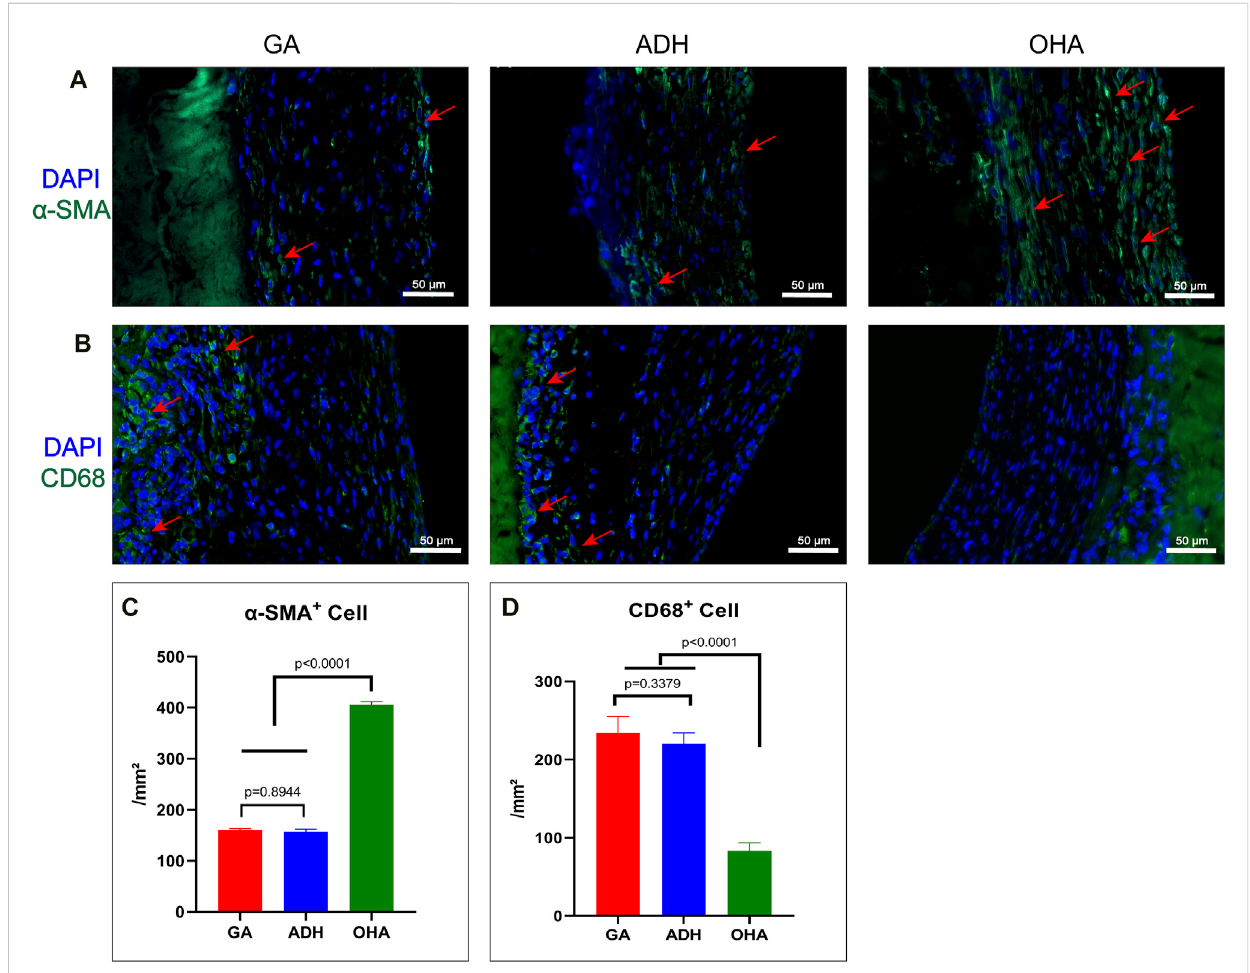
FIGURE 8 Immuno fl uorescence staining with α -SMA + antibody and CD68 antibody was performed to observe the in fi ltration of smooth muscle cells and macrophages in the neointima of the GA, ADH and OHA groups, and the corresponding quantitative analysis was performed at 4 weeks. Representative imagesofimmuno fl uorescencestainingwithanti- α -SMA(green)andCD68(green)antibodiesineachgroupat4 weeks.Nucleiwerecounterstainedwith DAPI. Scale bar, 50 μ m (A, B) . The number of α -SMA + and CD68 + cells in the neointima was quanti fi ed at 4 weeks (C, D) . Red arrows indicate the locations of positive